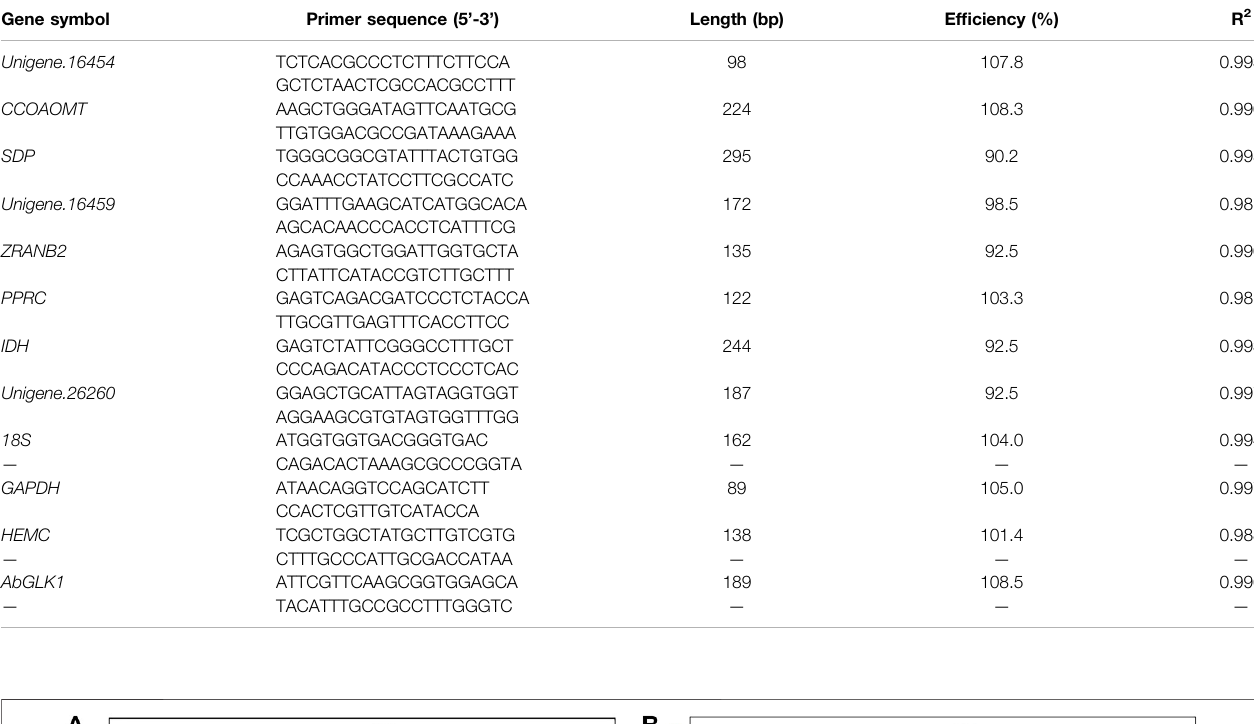
TABLE 3 | Primer used for quantitative real-time PCR analyses.